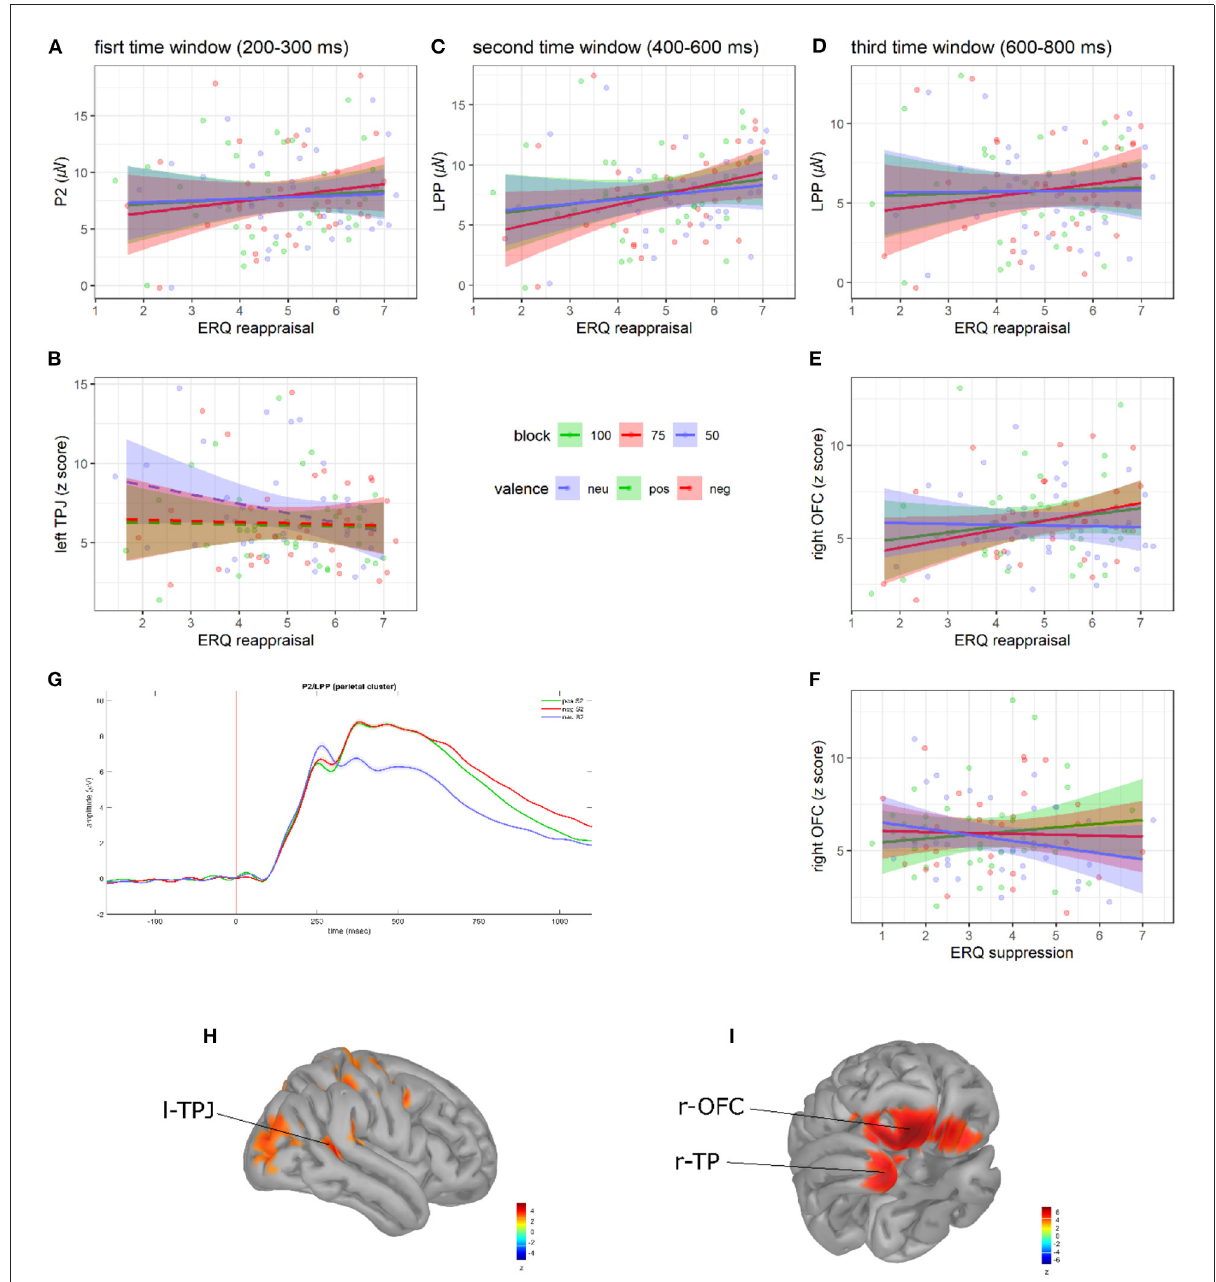
FIGURE3 Regression plots of ERQ reappraisal scores on (A) P2 amplitude, (C) early LPP amplitude, (D) late LPP amplitude, and (E) late r-OFC activity as a function of blocks. Regression plot of ERQ reappraisal scores on (B) l-TPJ activity as a function of S2 valence. Regression plot of ERQ suppression scores on (F) late r-OFC activity as a function of blocks. Shaded areas denote the 95% CI. Points represent individual observations. Grand average ERP waveforms to S2s (G) . Shaded areas denote SE. Adapted from Del Popolo Cristaldi et al. (2021d). Brain activity ( z -score) of the l-TPJ (H) , r-OFC, and r-TP (I)